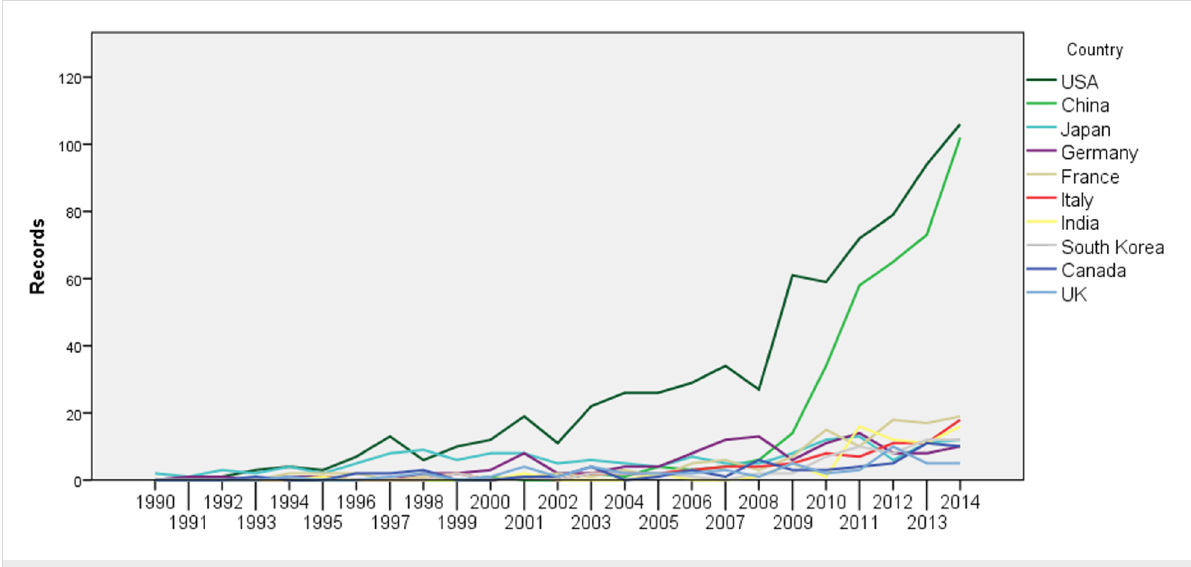
Figure 2: Publication trend of top 10 countries in 1990–2014.